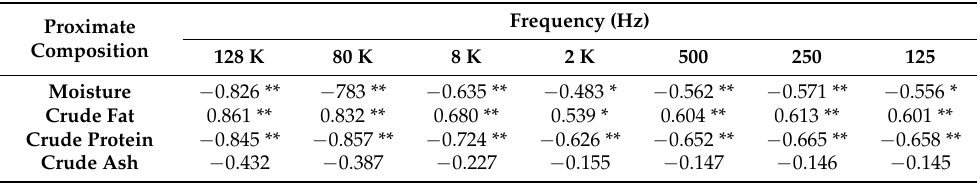
Table 3. Correlation coefficients between each impedance at different frequencies and composition analysis results.